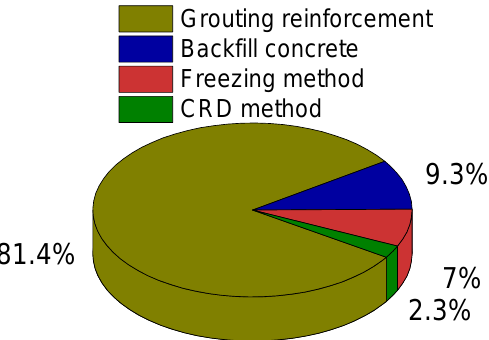
Figure 17. Proportions of formation reinforcement auxiliary construction methods.